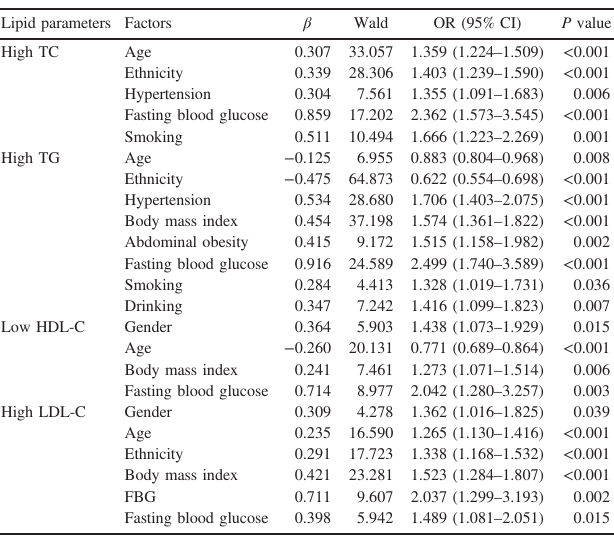
Table 5. Factors associated with the prevalence of lipid param- eters abnormality Lipid parameters